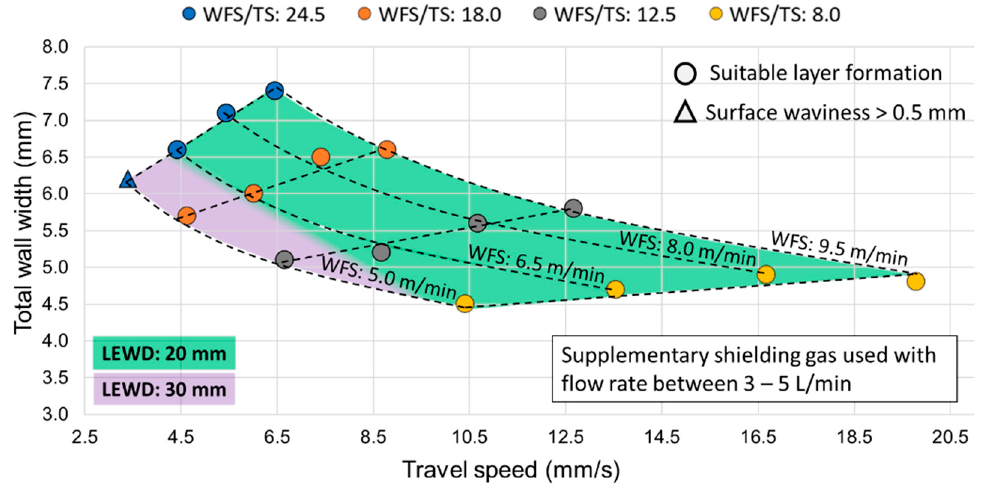
Figure 16. Experimentally based work envelope expanded after troubleshooting the excessive oxidation and SW issues.